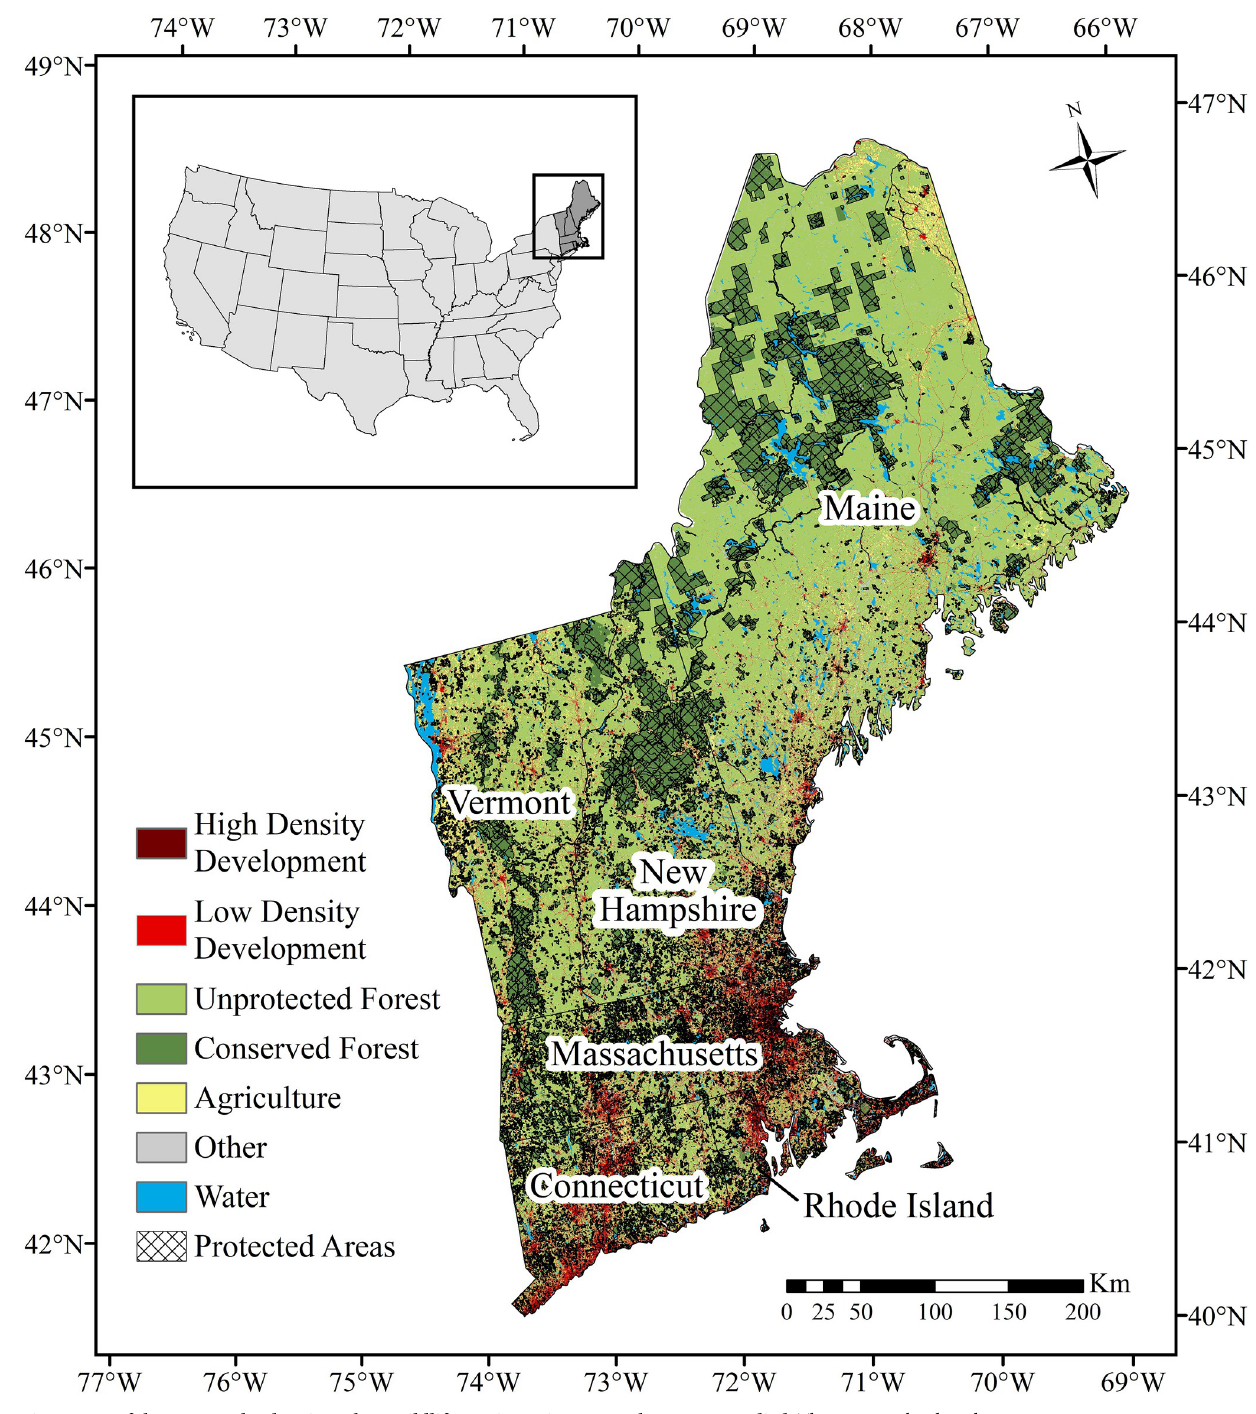
Fig 1. Map of the New England region where wildlife species resistance to change was studied. The New England study region encompasses six states— Connecticut, Maine, Massachusetts, New Hampshire, Rhode Island, and Vermont—and over 57,000 protected area parcels [28]. Data sources: U.S. Census Bureau [29], U.S. Geological Survey [28], and Plisinski et al. [30].